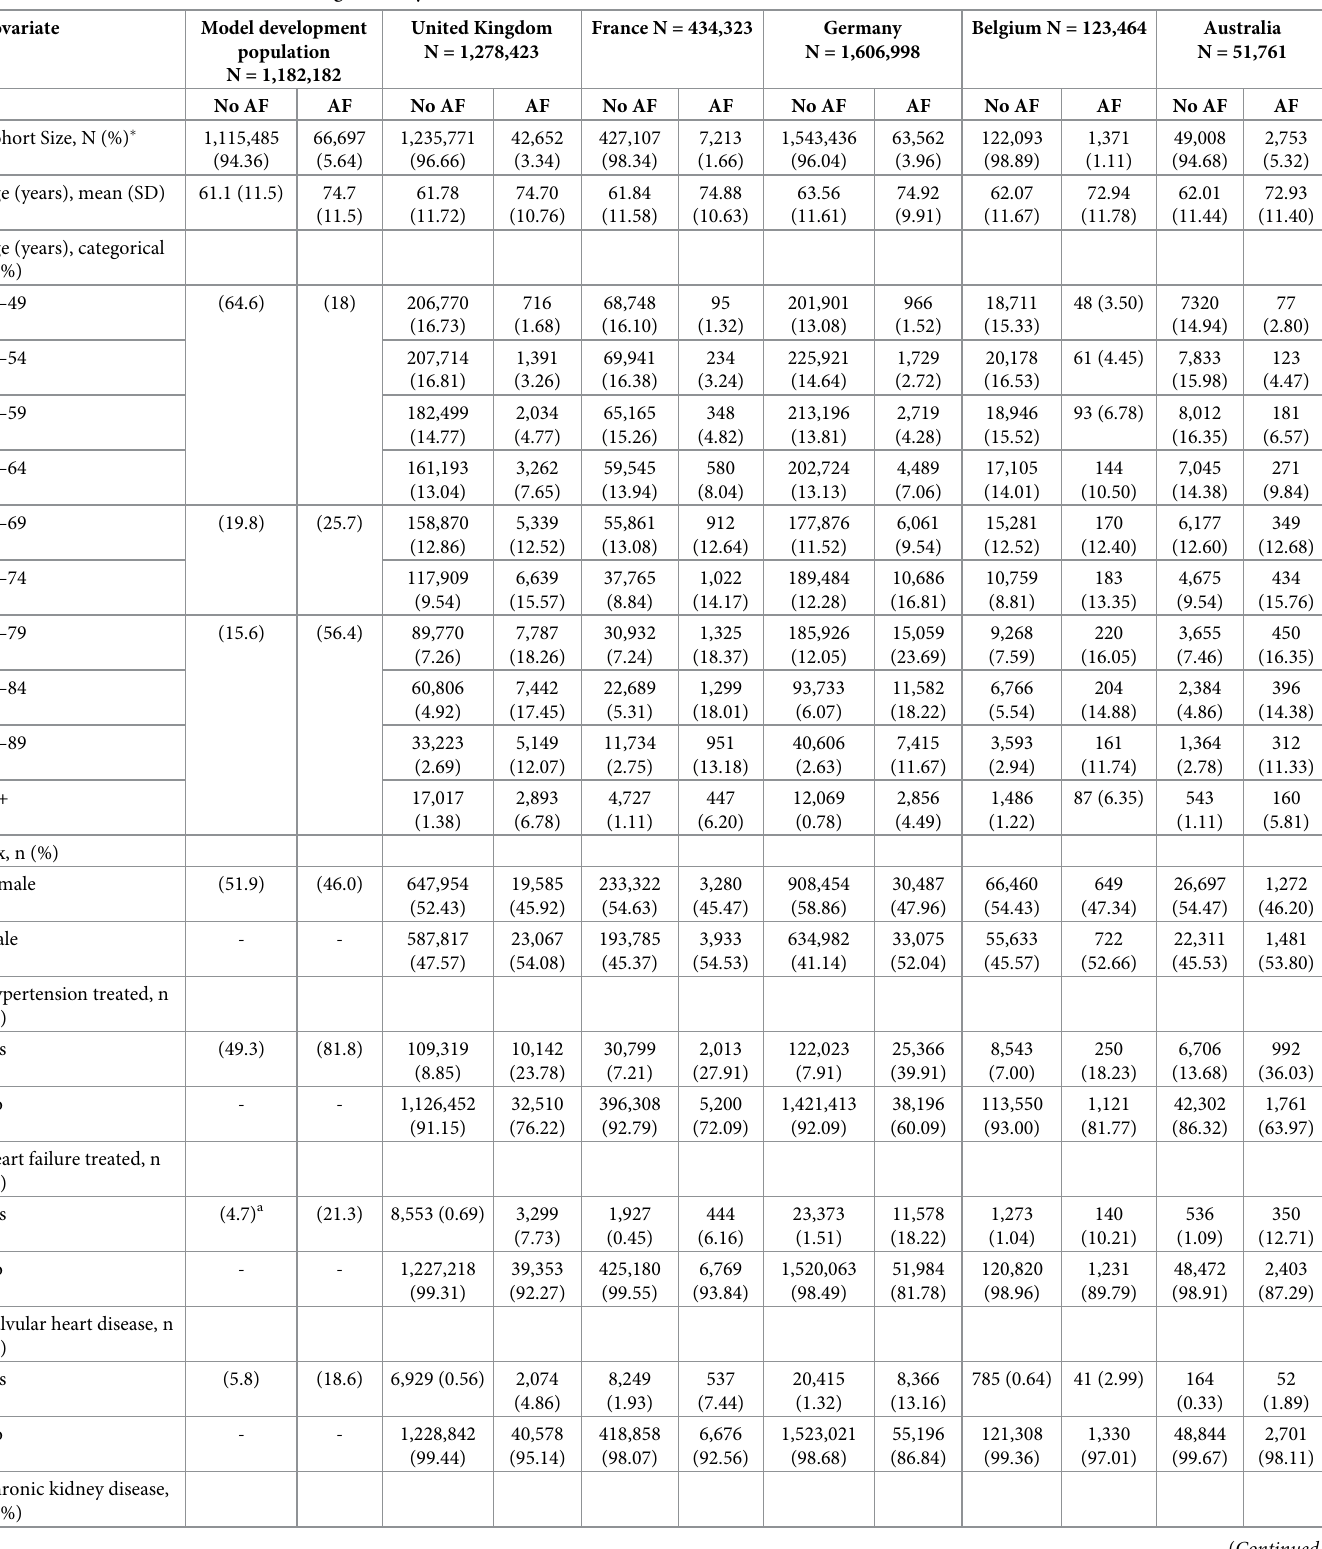
Table 2. Model relatedness between the original study and each of the validation databases.